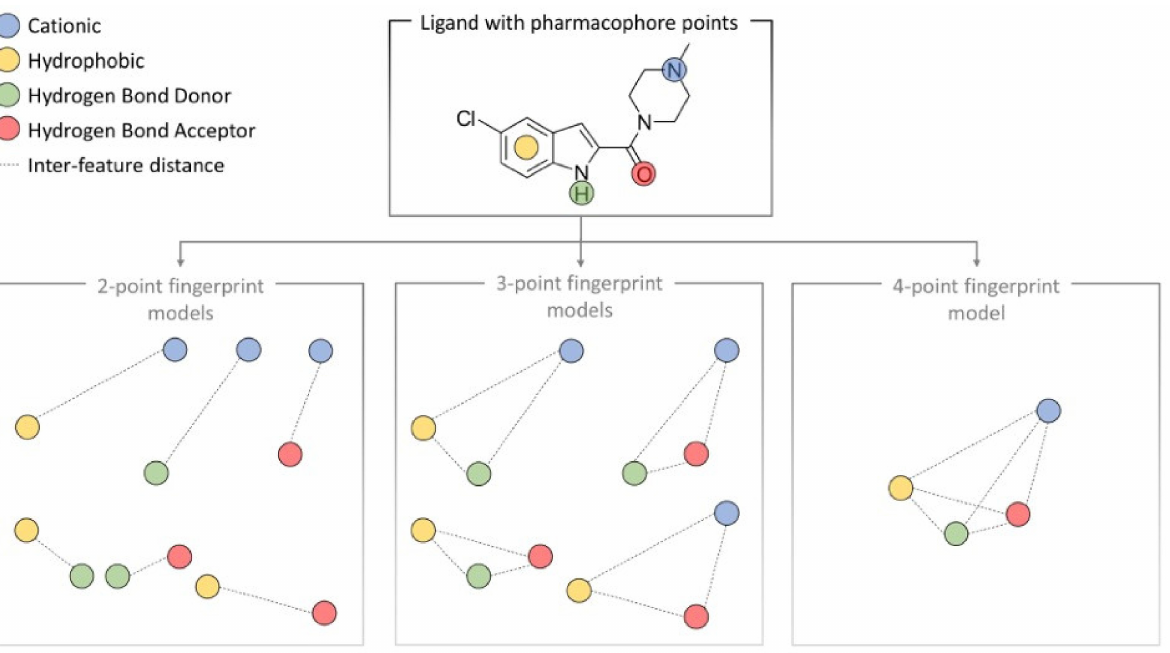
Figure 5. Ligand-based pharmacophore fingerprints encode the relationship between feature points based on the number of features and the measured topological distance between the